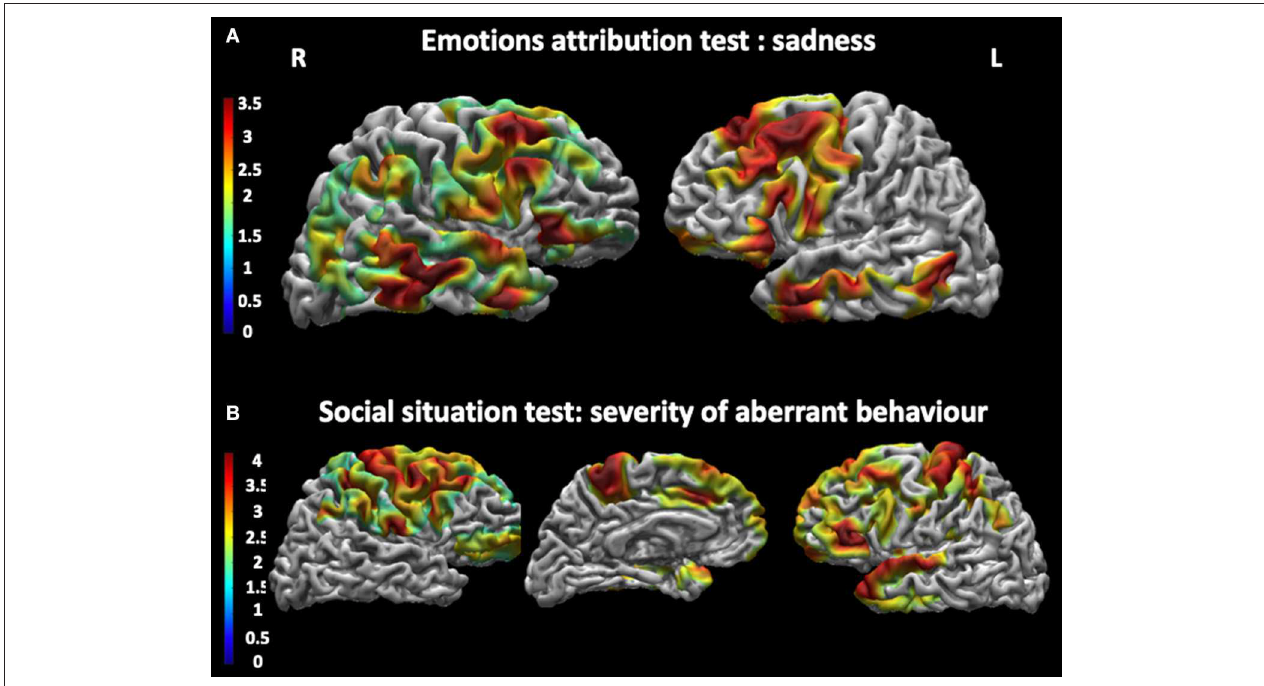
FIGURE 3 | Correlations between cortical thickness and performances at the Social Cognition Battery. (A) shows a significant positive correlation between cortical thickness and correct attribution of Sadness in the Emotions attribution test in the superior temporal gyrus, the right precentral gyrus, the right angular gyrus and the left medial frontal gyrus bilaterally. (B) shows a negative correlation between cortical thickness in the bilateral precuneus and in the left lateral occipital cortex and performance at the Social Situations Test, especially in Severity of Aberrant Behavior. The statistical comparisons were overlapped on MRIcron ch2bet template (https://www.nitrc.org/projects/mricron). L, left; R, right.